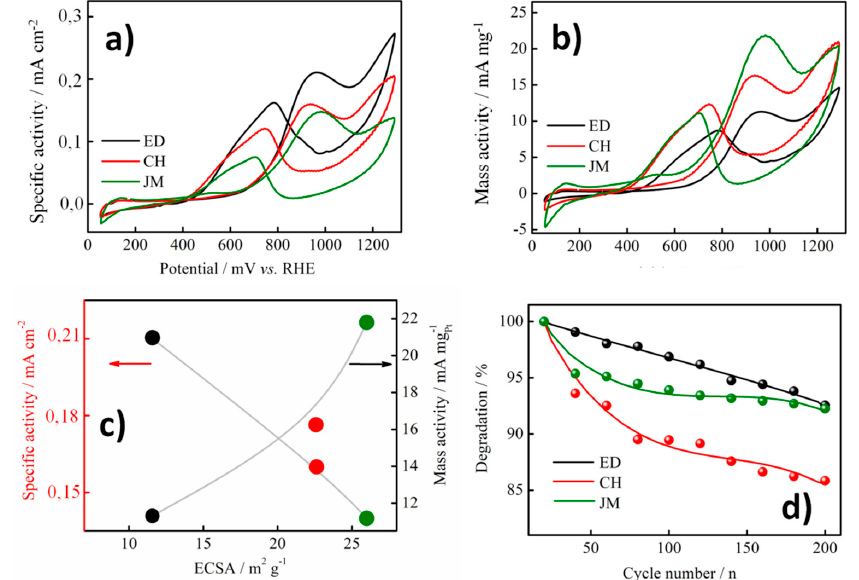
Figure 5. CV curves of the ED, CH, and JM Pt / C catalysts in 0.5 M H 2 SO 4 + 0.5 M EtOH, scan rate 20 mV s − 1 ( a , b ); specific activity and mass activity during the ethanol oxidation reaction (EOR) processes versus the ECSA of Pt / C catalysts, black balls—ED sample, red balls—CH sample, green balls—ED sample ( c ); durability of the ED, CH, and JM Pt / C catalysts in 0.5 M H 2 SO 4 + 0.5 M EtOH ( d ).